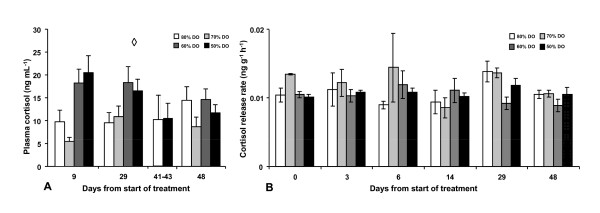
Plasma cortisol and cortisol release rate after long term hypoxia (Experiment 1). This experiment aimed at mimicking an overall situation often found in sea cages when water flow decreases and DO levels are reduced to levels as low as around 50%. Decreased water exchange rate may also cause increased concentrations of toxic metabolites. Four experimental oxygen regimes in triplicate tanks were created, fixed oxygen levels at 50%, 60%, 70% and 80%, automatically regulated by adjusting inflow (range 41-137 L min-1) in response to oxygen consumption of the fish. Blood was sampled for plasma cortisol measurements from all treatment groups at days 9, 29 and 48 and from the 80% and 50% DO between days 41-43. Non-invasive measurement of cortisol status of the fish was conducted by measuring the cortisol release rate into the water. Plasma cortisol levels were analysed using a general linear model with sampling occasion and DO treatment levels (with tank nested within treatment) as factors. DO levels had an effect on plasma cortisol levels (A) (p < 0.001) but were not affected by time (p = 0.607) and no interaction could be observed (p = 0.128). Further, SNK post hoc test grouped the 50% and 60% DO groups in one subset and the 70% and 80% DO groups in one subset at day 9, 29 and 48. No differences could be observed in plasma cortisol between 80% and 50% DO levels in fish sampled for intestinal barrier function between days 41-43. No major differences could be observed in the cortisol release rate between treatment groups (B). All data are expressed as means ± SEM and p < 0.05. The overall effect of treatment is indicated by ◊.